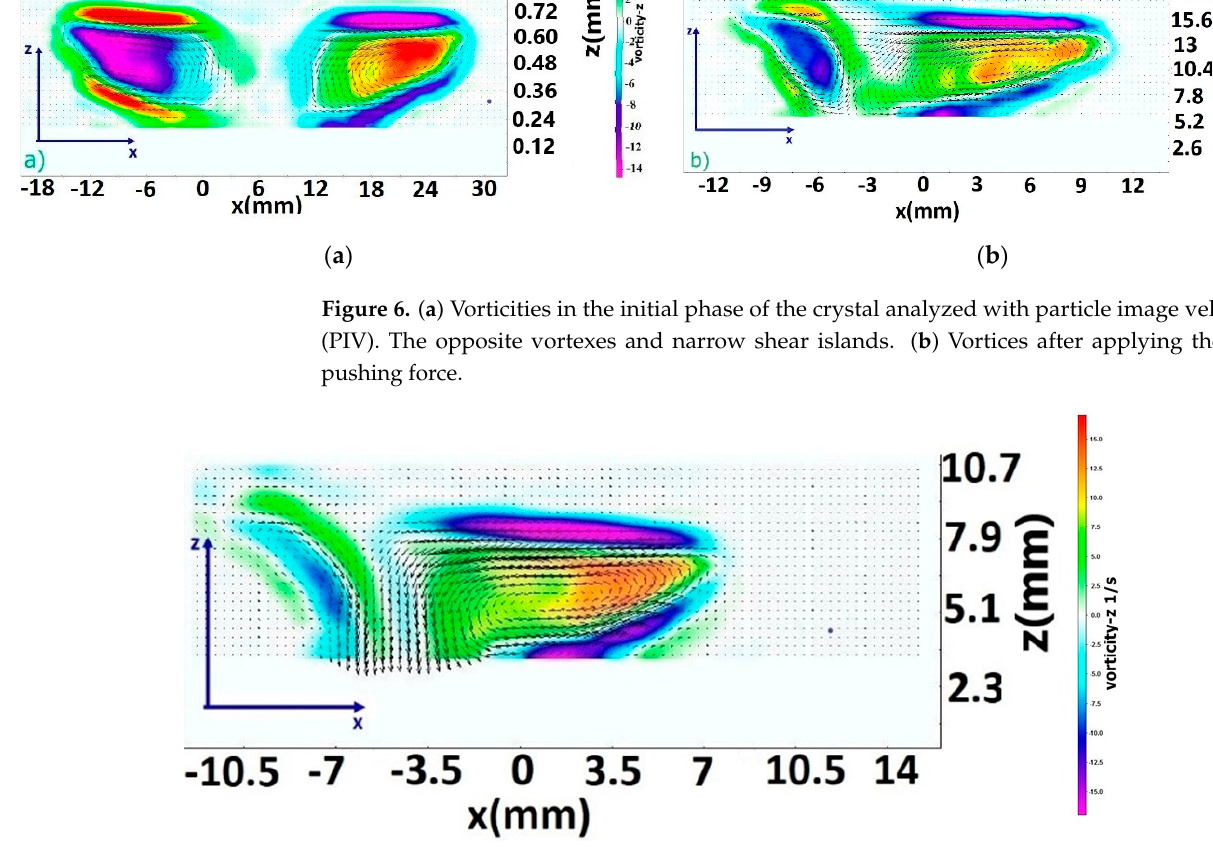
Figure 7. Vorticities after the crystal is pushed by neutral gas and particles start to fall down.